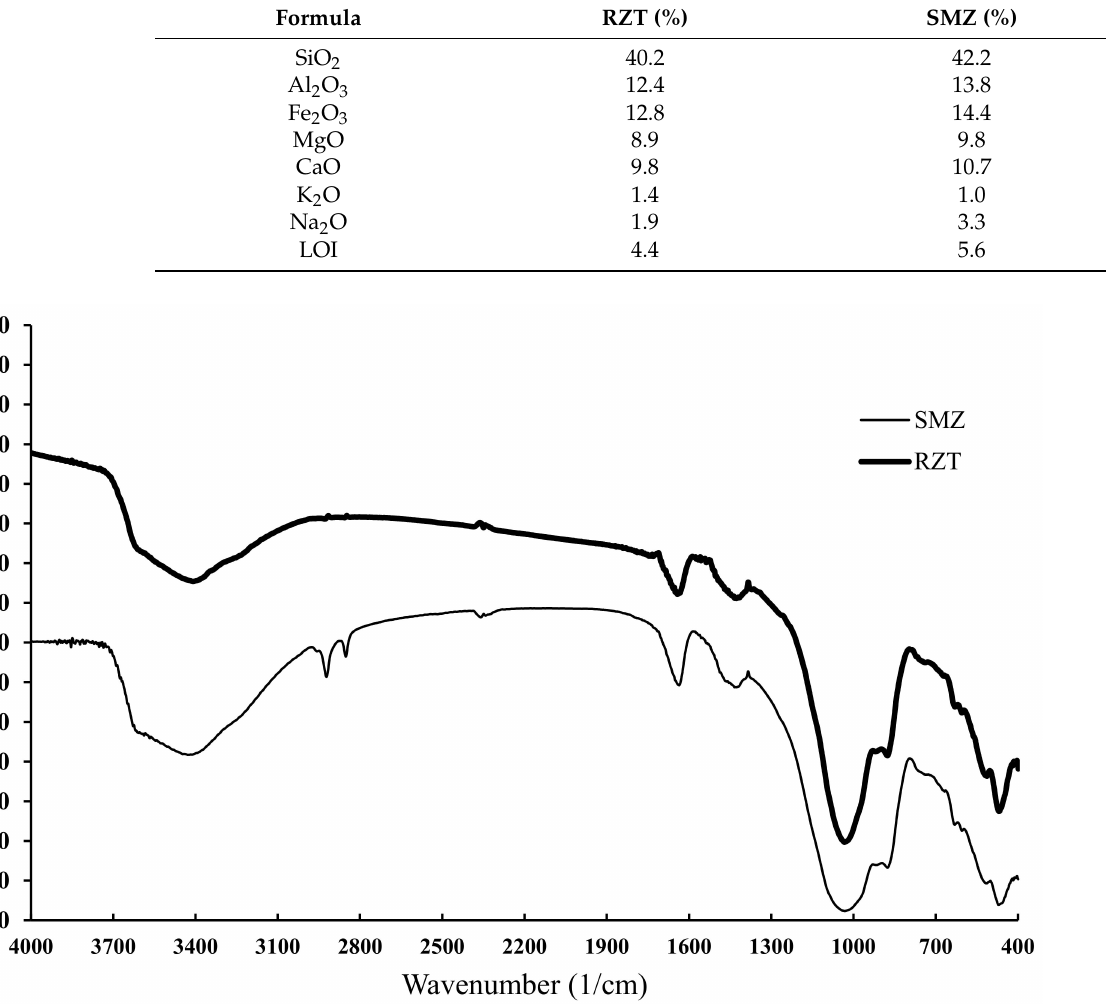
Table 2. Result of XRF analysis for RZT and SMZ.